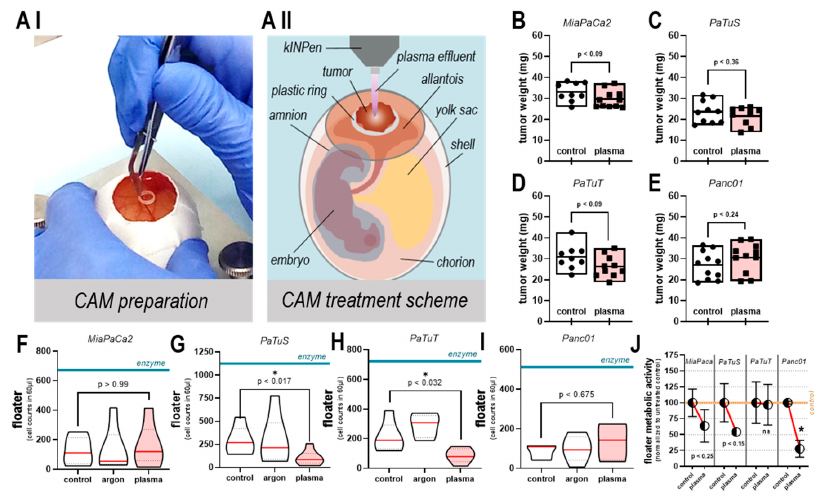
Figure 6. Plasma treatment did not increase tumor growth or the number of detached cells in ovo. ( A I ) preparation of a chicken egg for tumor implantation on a plastic ring; ( A II ) scheme of the anatomy of the chorion allantois membrane (CAM) and treatment of a solid pancreatic tumor tissue with the kINPen argon plasma jet (day 12 and 14); tumor weight after excision (day 14) of ( B ) MiaPaCa2, ( C ) PaTuS, ( D ) PaTuT, and ( E ) Panc01 cells; rinsing of tumors with 150 µL growth medium to collect cells detached per se or potentially through plasma treatment procedure and ( F – I ) the quantification of the counts of detached cells (floaters) via nuclear counterstaining and flow cytometry collected of tumors immediately after either being left untreated or treated for 60s with argon gas (argon) or plasma; enzymes (accutase or trypsin) digestion for 5 min served as a positive control (blue horizontal line); ( K ) second set of samples from ( G – J ) but incubated for 6 d following collection from tumors, and assessment of metabolic activity. Data are displayed as mean with the minimum, maximum, and single values ( B – E ) or median with minimum, maximum and quartiles as dashed lines ( F – I ) of at least four to five eggs per group and experiment; ( J ) are mean values ± SEM as representatives of four independent experiments.